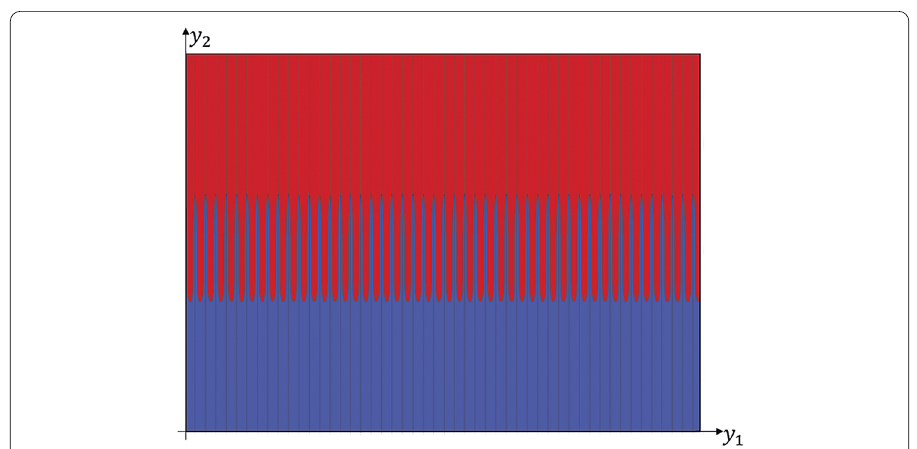
Figure 2 Numerical homogenization for t = 5.5. The gradual growth of the number of capillaries leads to homogenization of the liquid motion.